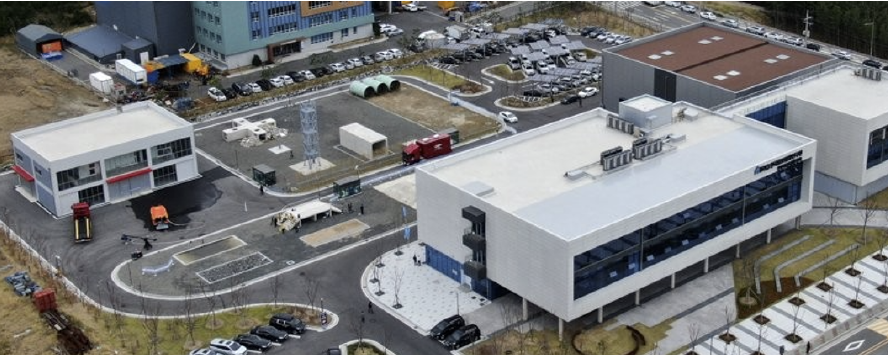
Figure 1. The experimental environment including an office building, experimental facilities, and outdoor roads.